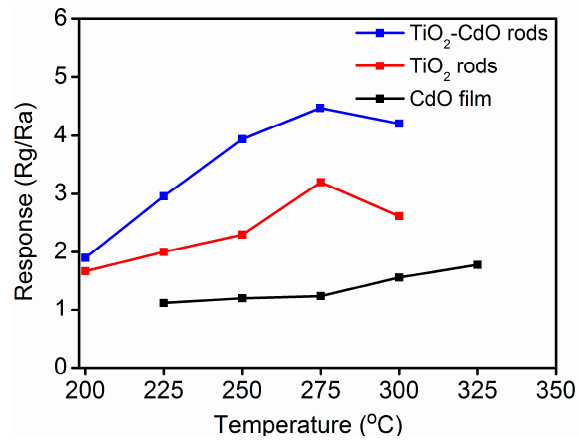
Figure 6. Gas sensing response value vs. operating temperature of the CdO film, TiO 2 rods, and TiO 2 –CdO